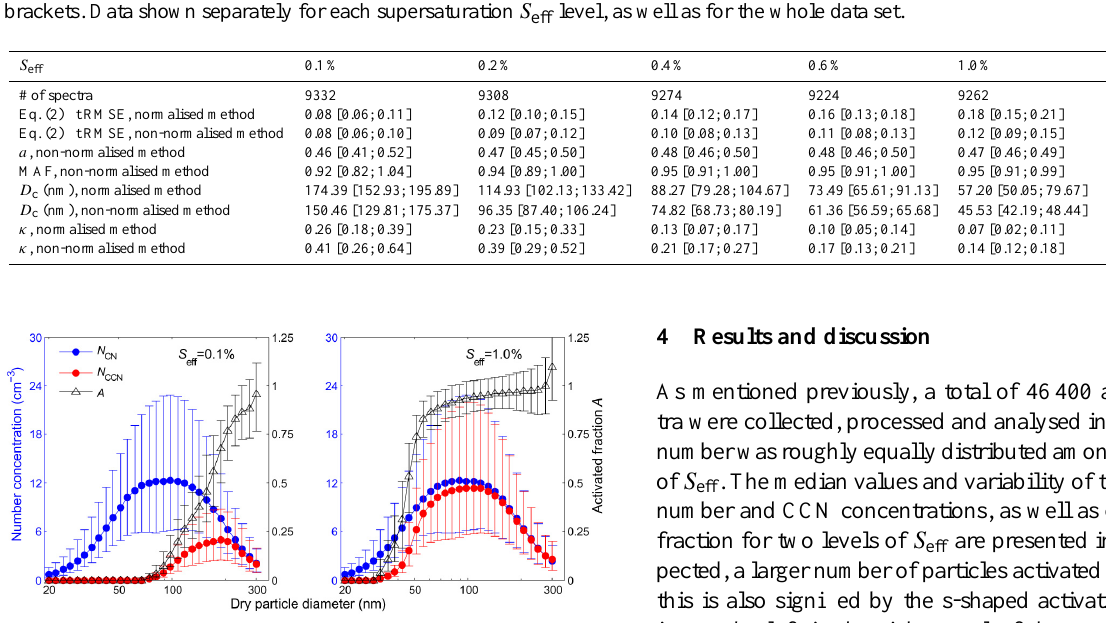
Fig. 3. Median N CN , N CCN and A per size bin for the whole data set for two levels of supersaturation S eff . Left panel: S eff = 0.1%; right panel: S eff = 1.0%. Error bars show 25th and 75th